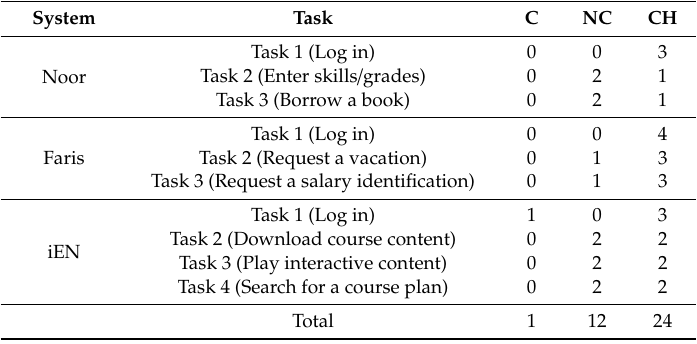
Table 10. Frequency of the completion status for each task: completed (C), not completed (NC), or completed with help (CH).